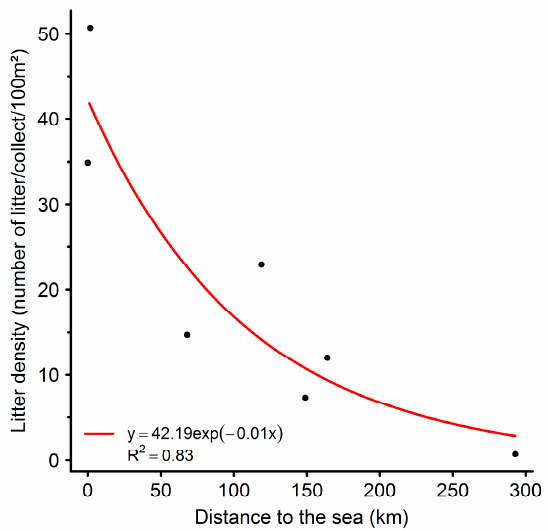
Figure 4. Relationship between litter density and distance to the sea excluding the BBZ sampling site.